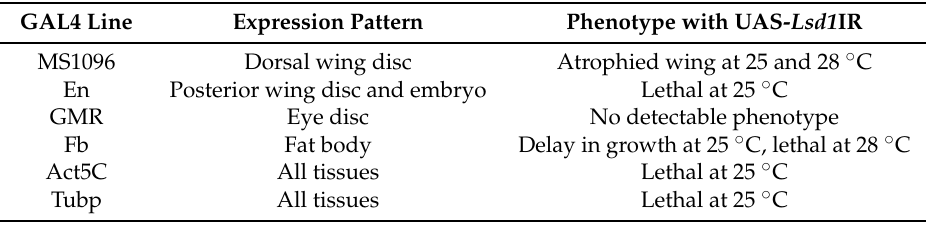
Table 1. Summary of phenotypes induced by knockdown of Lsd1 with various GAL4 driver